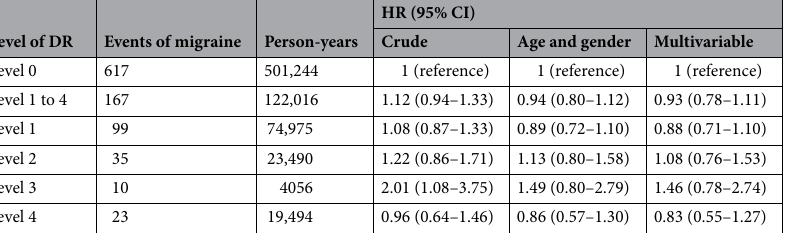
Table 4. Incident migraine in patients with diabetes according to level of diabetic retinopathy. Hazard ratio (HR) with 95% confidence interval (CI) for 5-year incident migraine after the index date for patients with diabetes mellitus screened for diabetic retinopathy (DR) according to level of DR (level 0 used as reference). CI confidence interval. Level of DR given by the worse eye. Multivariable model adjusted adjusted for sex, age, marital status, use of lipid lowering drugs and Charlson comorbidity index: myocardial infarct, congestive heart failure, cerebrovascular disease, chronic pulmonary disease, connective tissue disease/ rheumatologic disease, ulcer disease, mild liver disease, hemiplegia/hemiplegia or paraplegia, any malignancy (including leukemia and lymphoma), moderate-severe liver disease, solid metastatic tumor, and acquired immunodeficiency